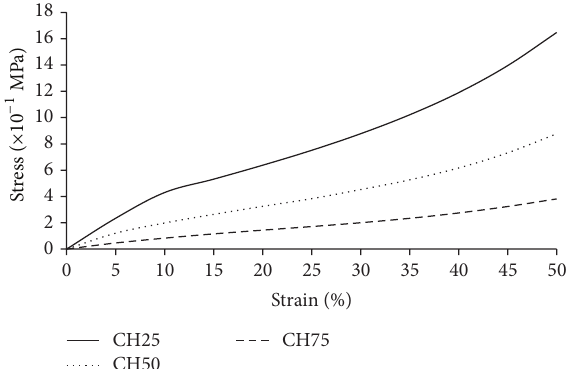
Figure 4: The mechanical properties of PVA-g-chitosan 3D scaf-